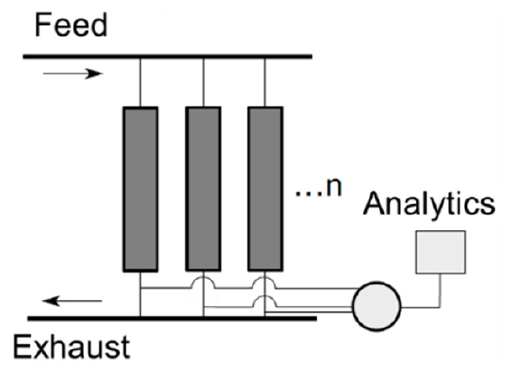
Figure 19. Schematic representation of a high throughput reactor system with online analytical methods. The sampling is carried out via multiport valves at the reactor outlet.